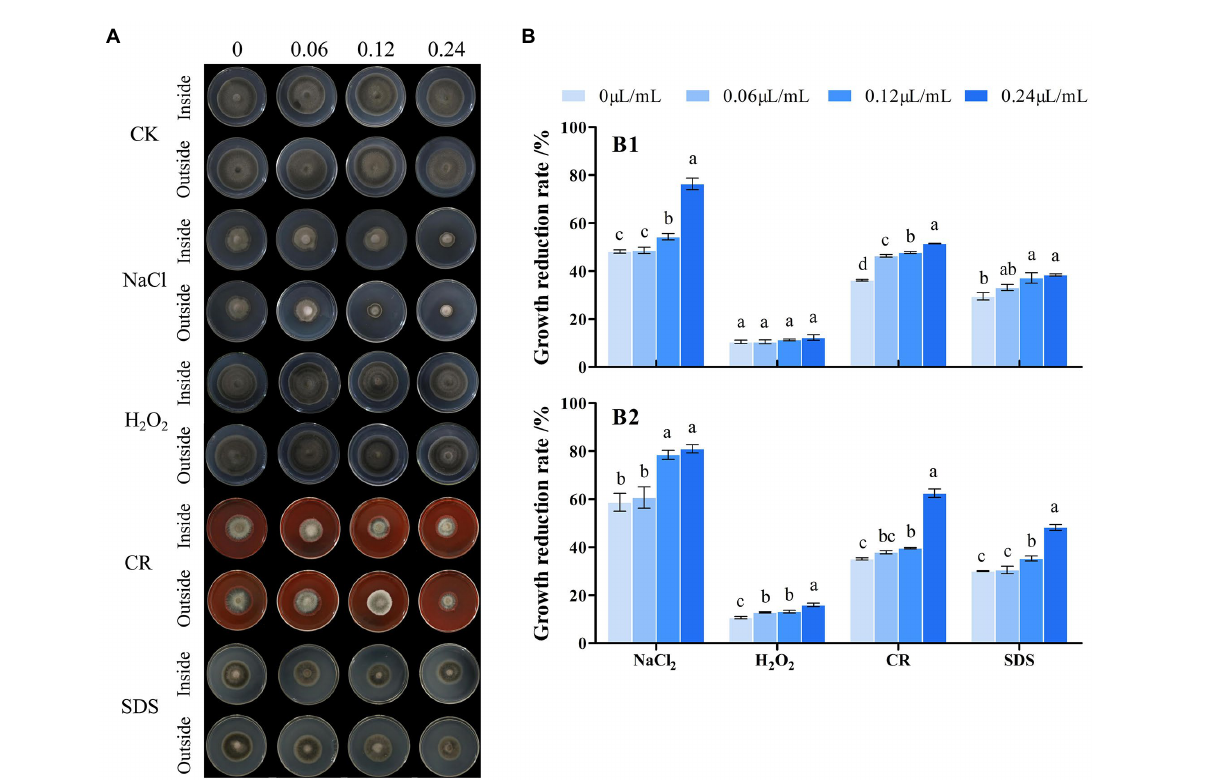
FIGURE 6 Influence of CVR treatment on stress resistance. Image of cultured under different conditions (A) . Growth reduction rate (%), (B) of inside (B1) and outside (B2) fungal colonies grown at 25 ° C for 8 days on PDA plates supplemented with NaCl (0.5 M), CR (Congo red 5 μg/ml), H 2 O 2 (1.5 mM), and SDS (0.1 mg/ml), respectively. Different letters represent significant differences at the level of p <